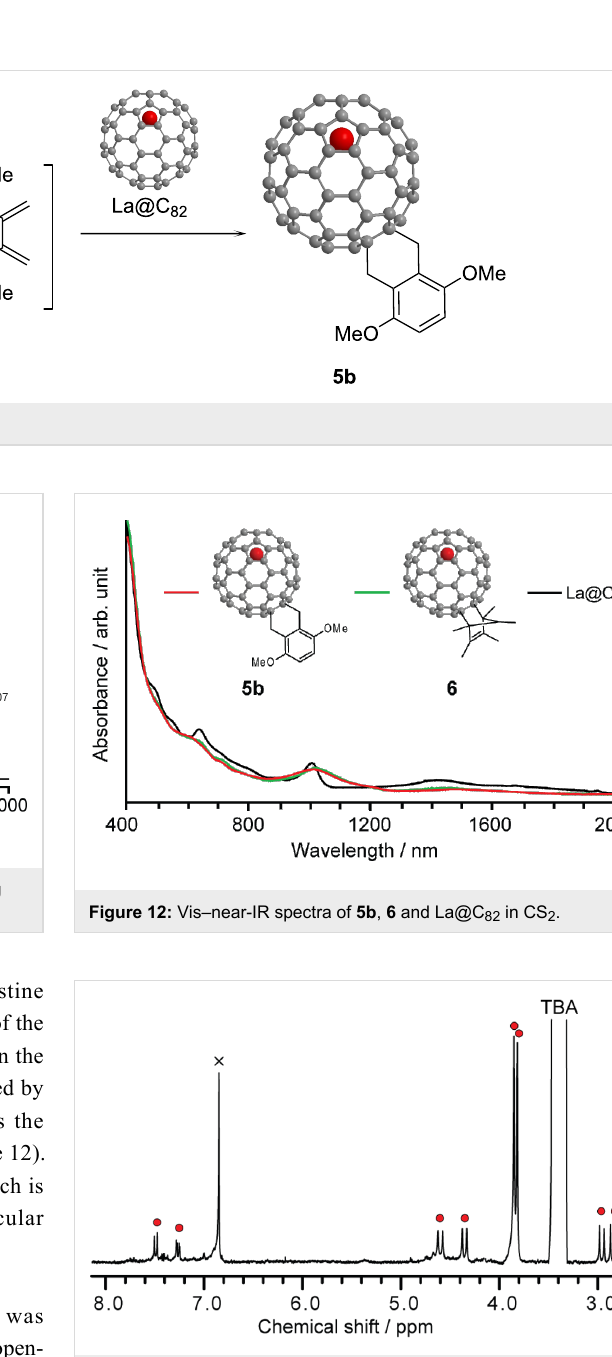
Figure 13: 1 H NMR spectrum of [ 5b ] − in acetone- d 6 /CS 2 (3/1 = v/v) at 223